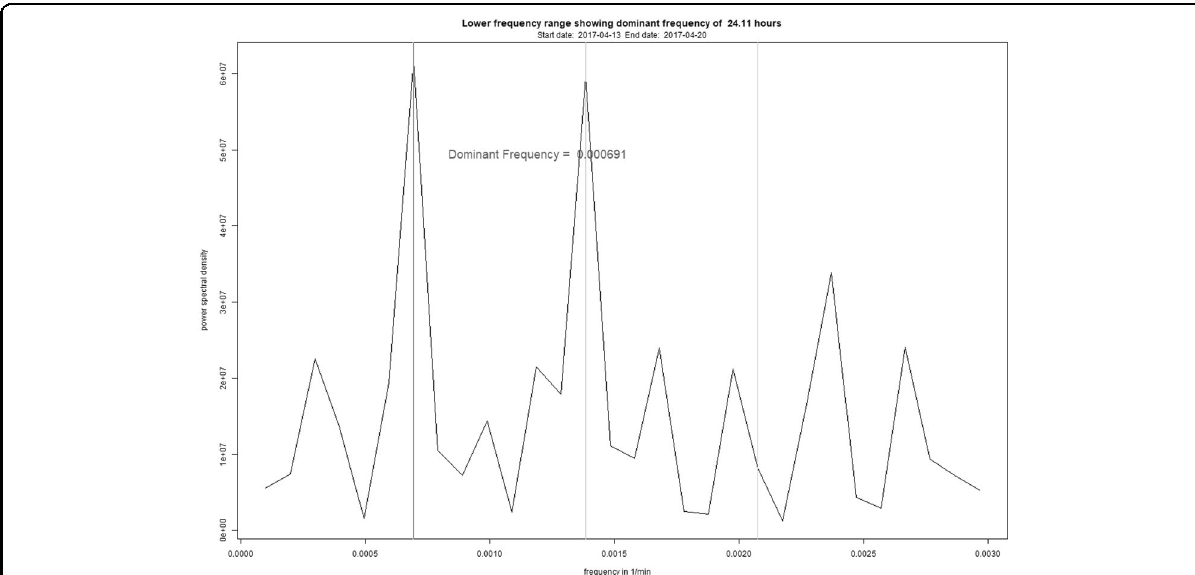
Fig. 2 Frequency spectrum of patient 11 showing the dominant frequency (dark gray) and its two subsequent harmonic frequencies (light gray), one day before transitioning towards an atypical 12-h rhythm. The y-axis shows the power spectrum density in U 2 while the x-axis shows the frequency in 1/min.